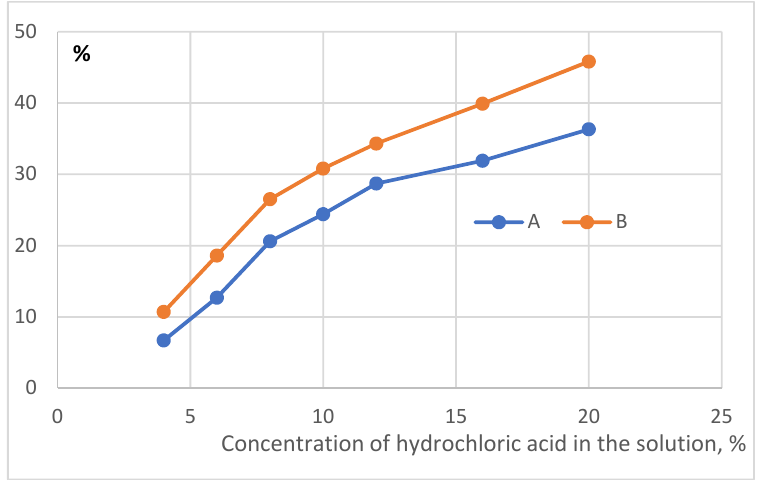
Figure 8. Average Magnesium extraction (%) without mechanical activation (A) and with mechanical activation (B).